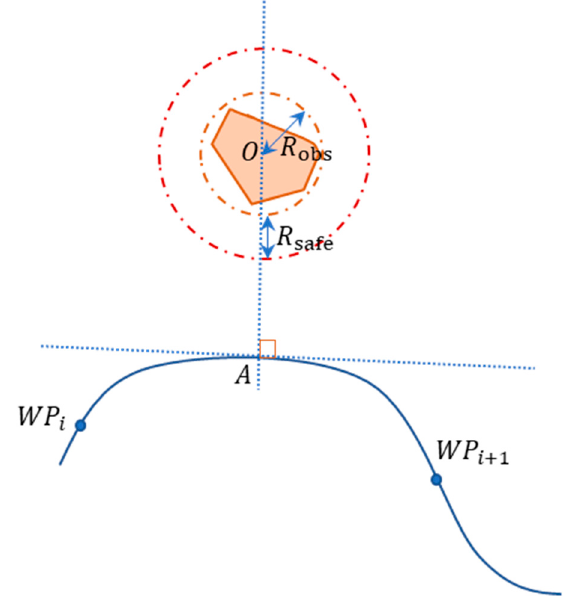
Figure 5. Path planning to avoid static